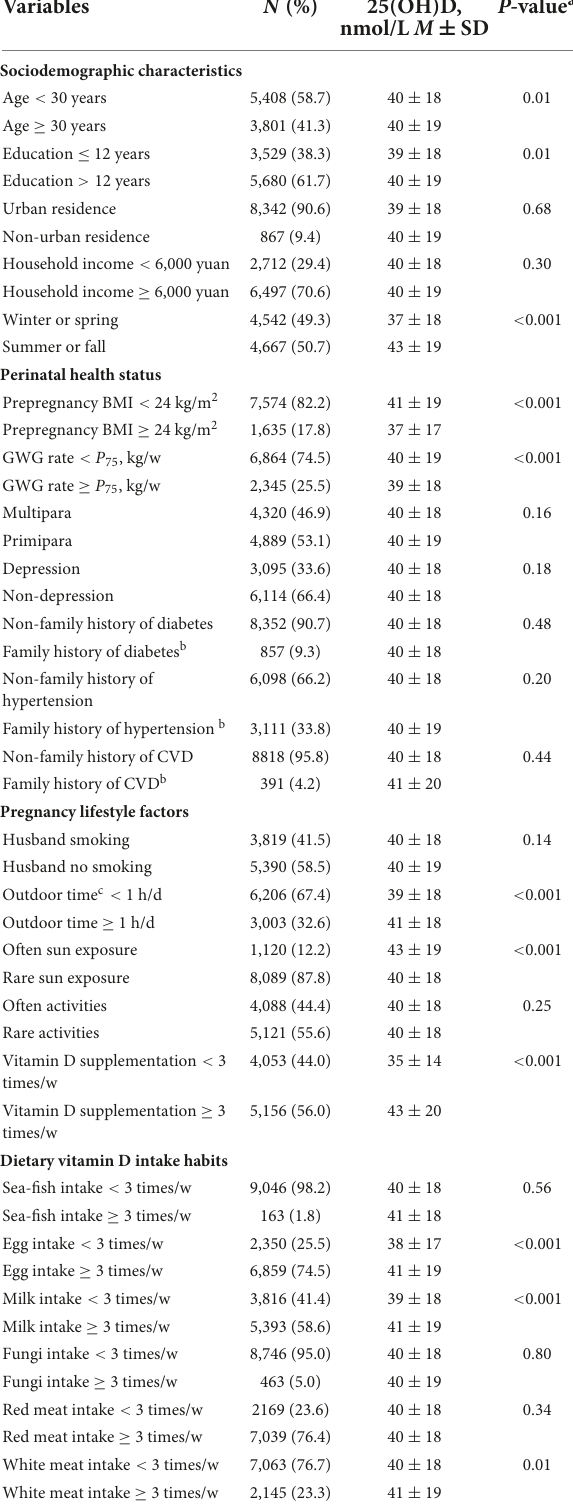
TABLE 1 Characteristics of the study